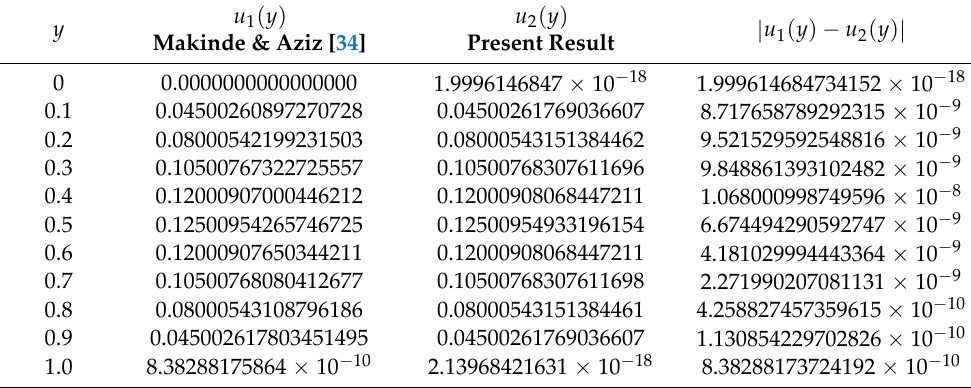
Table 5. Validation with previous result when Bi 1 = Bi 2 = 10, Gr = 0 = γ = η , α = 0.1 .